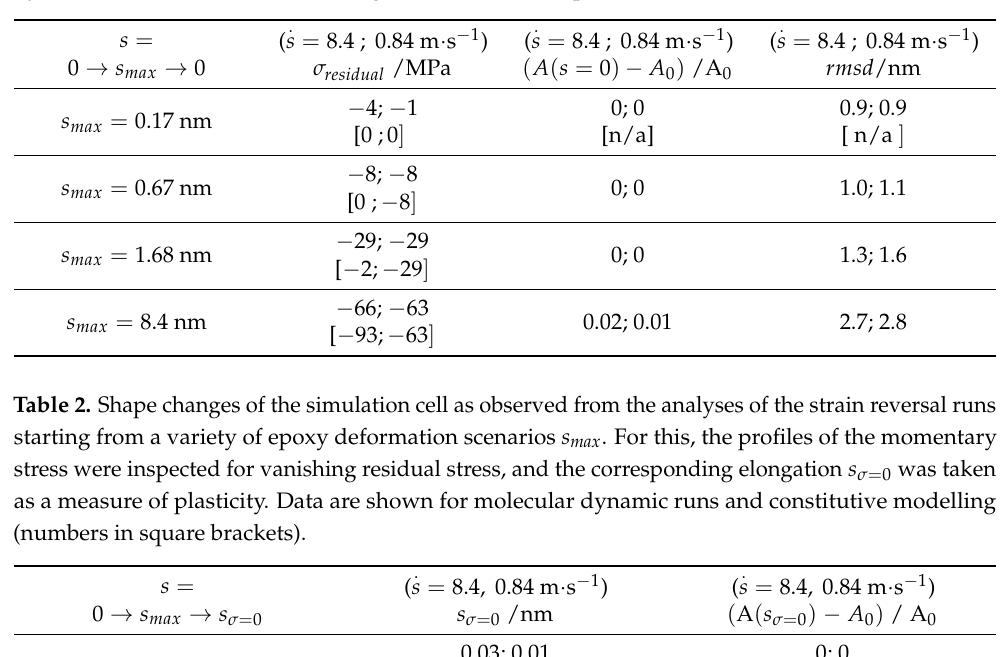
Table 1. Residual stress, change of the simulation cell (cross-section area A normal to the applied elon- gation s ), and atomic displacements ( rmsd ) for cyclic deformation runs, as observed from molecular dynamics and constitutive modelling (data denoted in square brackets).